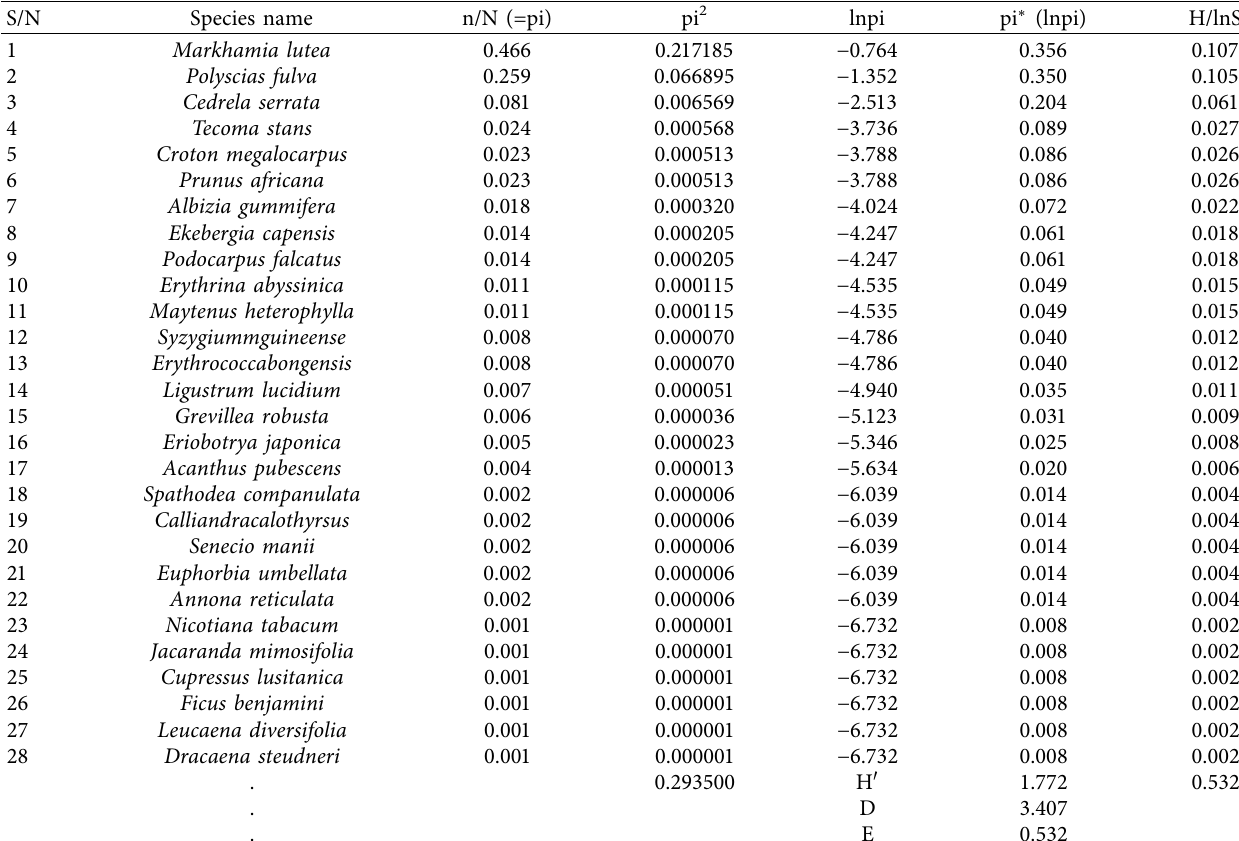
Figure 11: Family importance values observed in the self-regenerated secondary forest in Ruhande Arboretum, Huye, Rwanda. Table 2: Shannon–Weiner (H), species evenness (E), and Simpson’s diversity (D) indices of woody species identified in the study area. Pi stands for the proportion of individuals of a species/plot (n) to the total population of that species (N); ln is the natural log and S denotes the species richness in the study